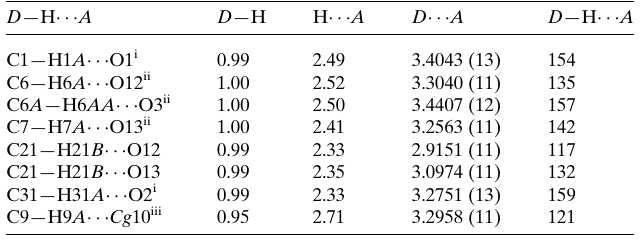
Table 1 Hydrogen-bond geometry (A˚ , (cid:4) ). Cg 10 is the centroid of the C32–C37